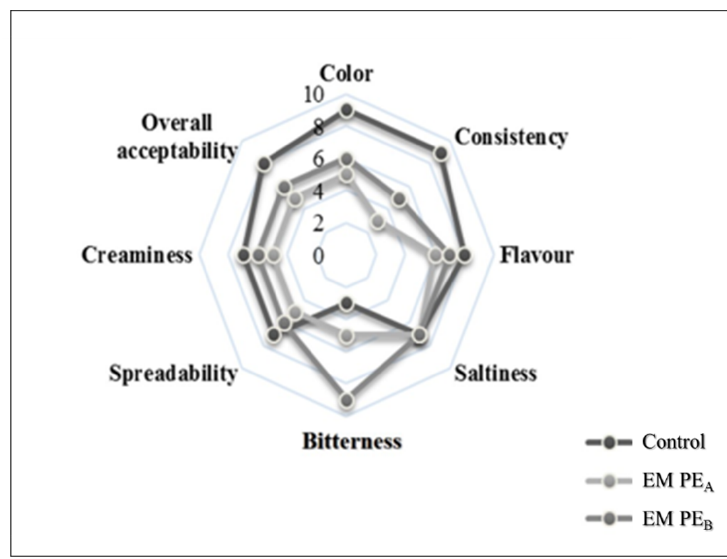
Figure 4. Spider plot of sensory attributes of mayonnaise samples .